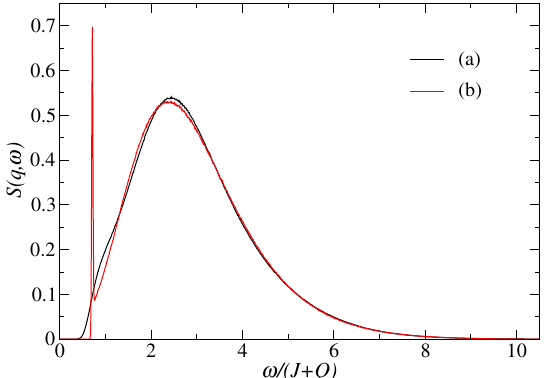
FIG. 15. The q ¼ ð π ; 0 Þ dynamic structure factor of the J - Q model at Q=J ¼ 4 obtained using SAC with the two para- metrizations of the spectrum in Figs. 1(a) and 1(b). The relative weight of the leading δ function in (b) is